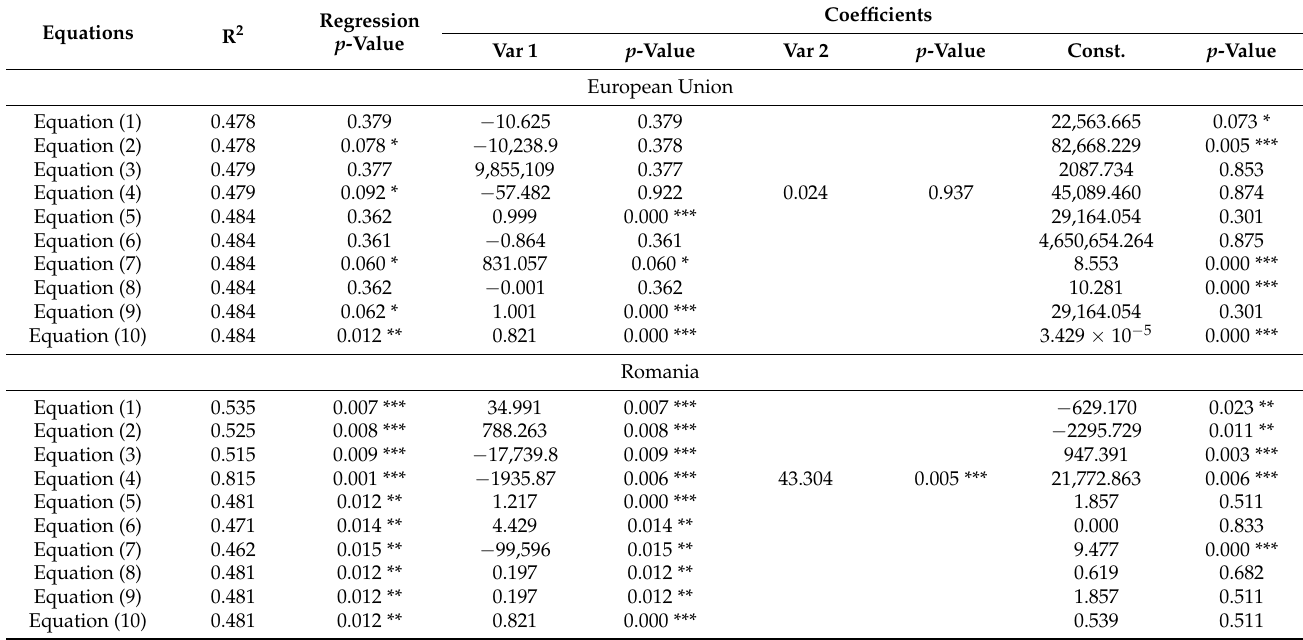
Table A3. Estimation of parameters of linear and nonlinear equations for GDP and FEC (2009–2020).